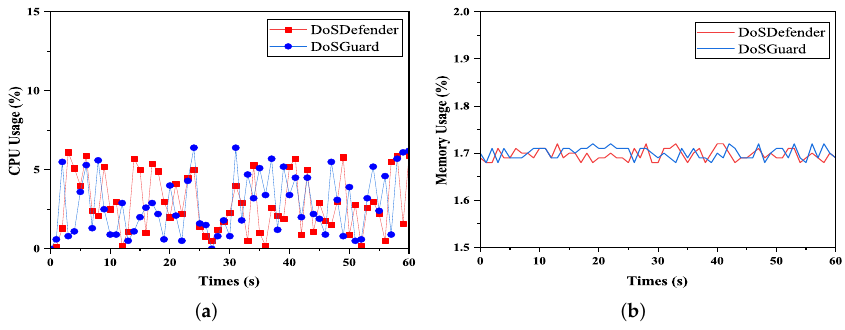
Figure 9. Overload comparison. ( a ) CPU Usage. ( b ) Memory